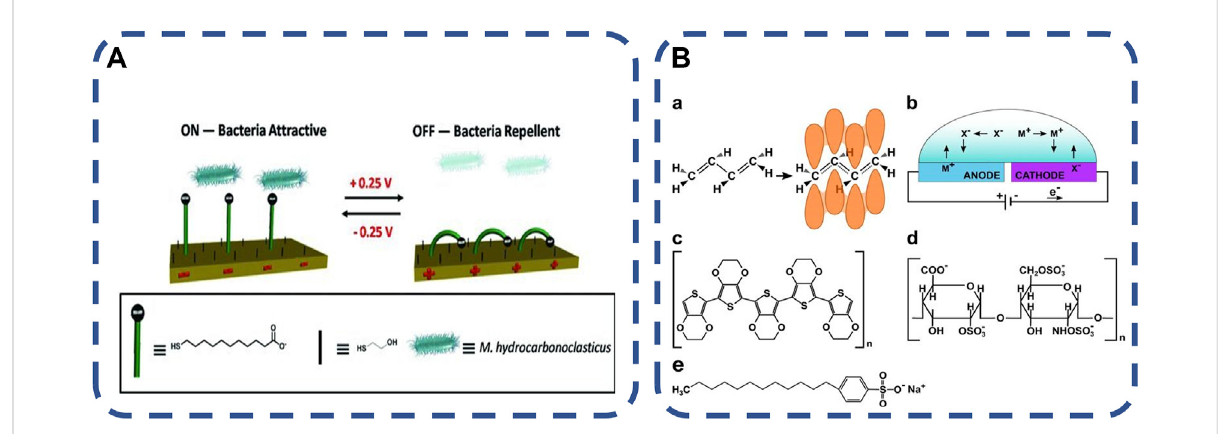
FIGURE 6 (A) Schematic diagram of an electrically switchable two-component SAM, which can switch its molecular conformation reversibly and rapidly according to the applied potential (Pranzetti et al., 2013). Copyright 2013, Adv Mater, (B) Chemical structure and electrochemical redox reaction in conductive polymer. a Chemical structure of the conductive polymer polyacetylene (left) and its resonance hybrid (right). b Ion fl ux in a conductive polymer-basedelectrochemicalcell.m+andx − representpositivelyandnegativelychargedions,respectively.